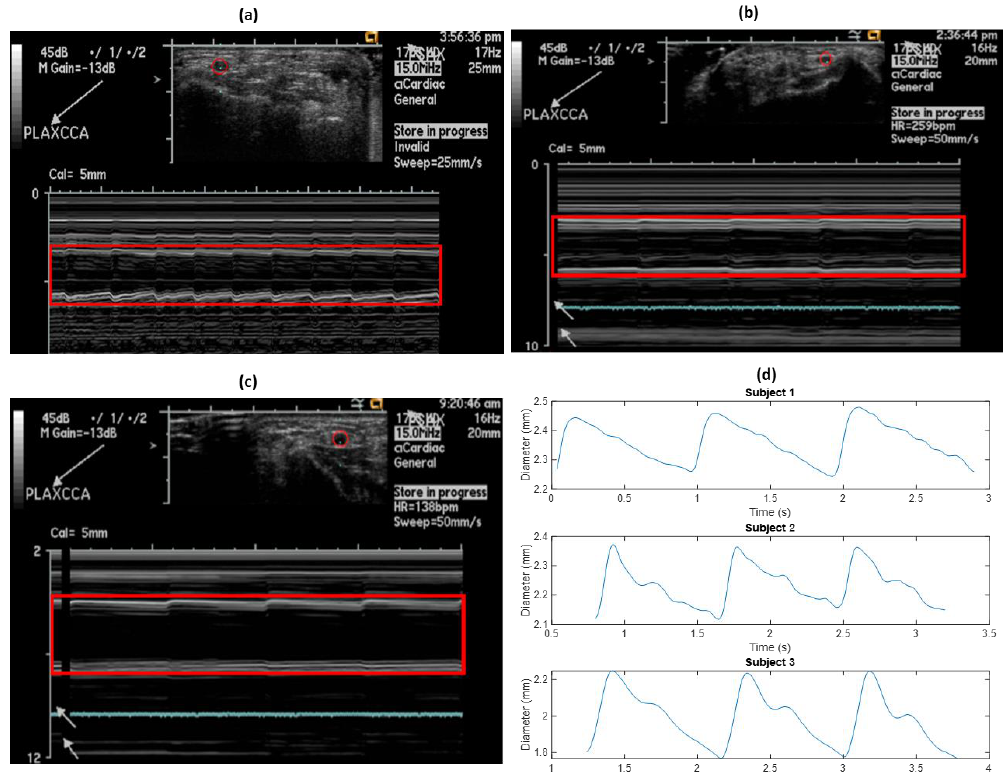
Figure 5. ( a – c ) Radial artery diameter changes measured using ultrasound for subjects 1, 2 and 3, respectively. The artery is outlined by a red circle and the corresponding M-mode diameter wave is outlined using a red rectangle. ( d ) Extracted diameter waveforms for the subjects from ultrasound measurements.